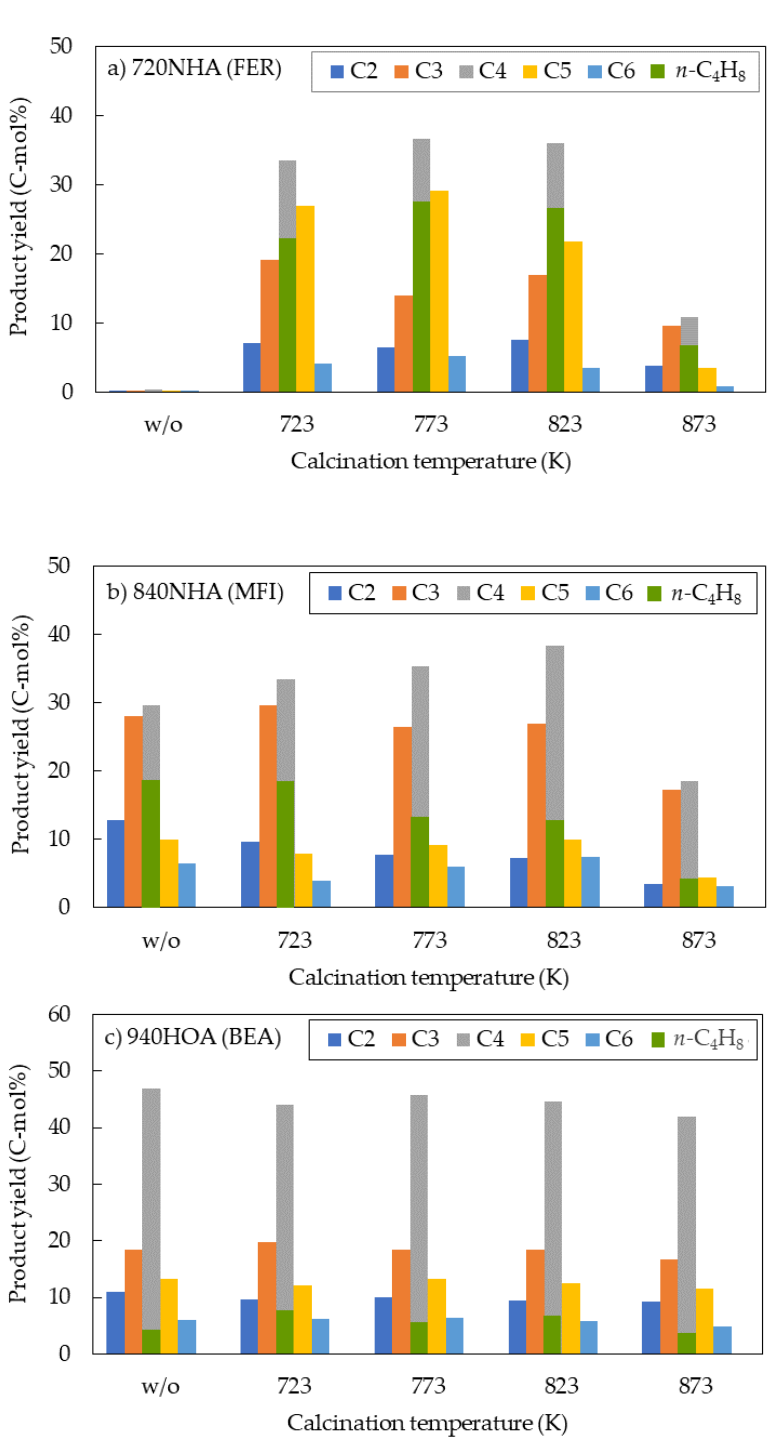
Figure 3. Relationship between calcination temperature and product yield for each carbon num- ( a ) 720NHA (FER); ( b ) 840NHA (MFI); and ( c ) 940HOA ber: ( a ) 720NHA (FER); ( b ) 840NHA (MFI); and ( c ) 940HOA (BEA).